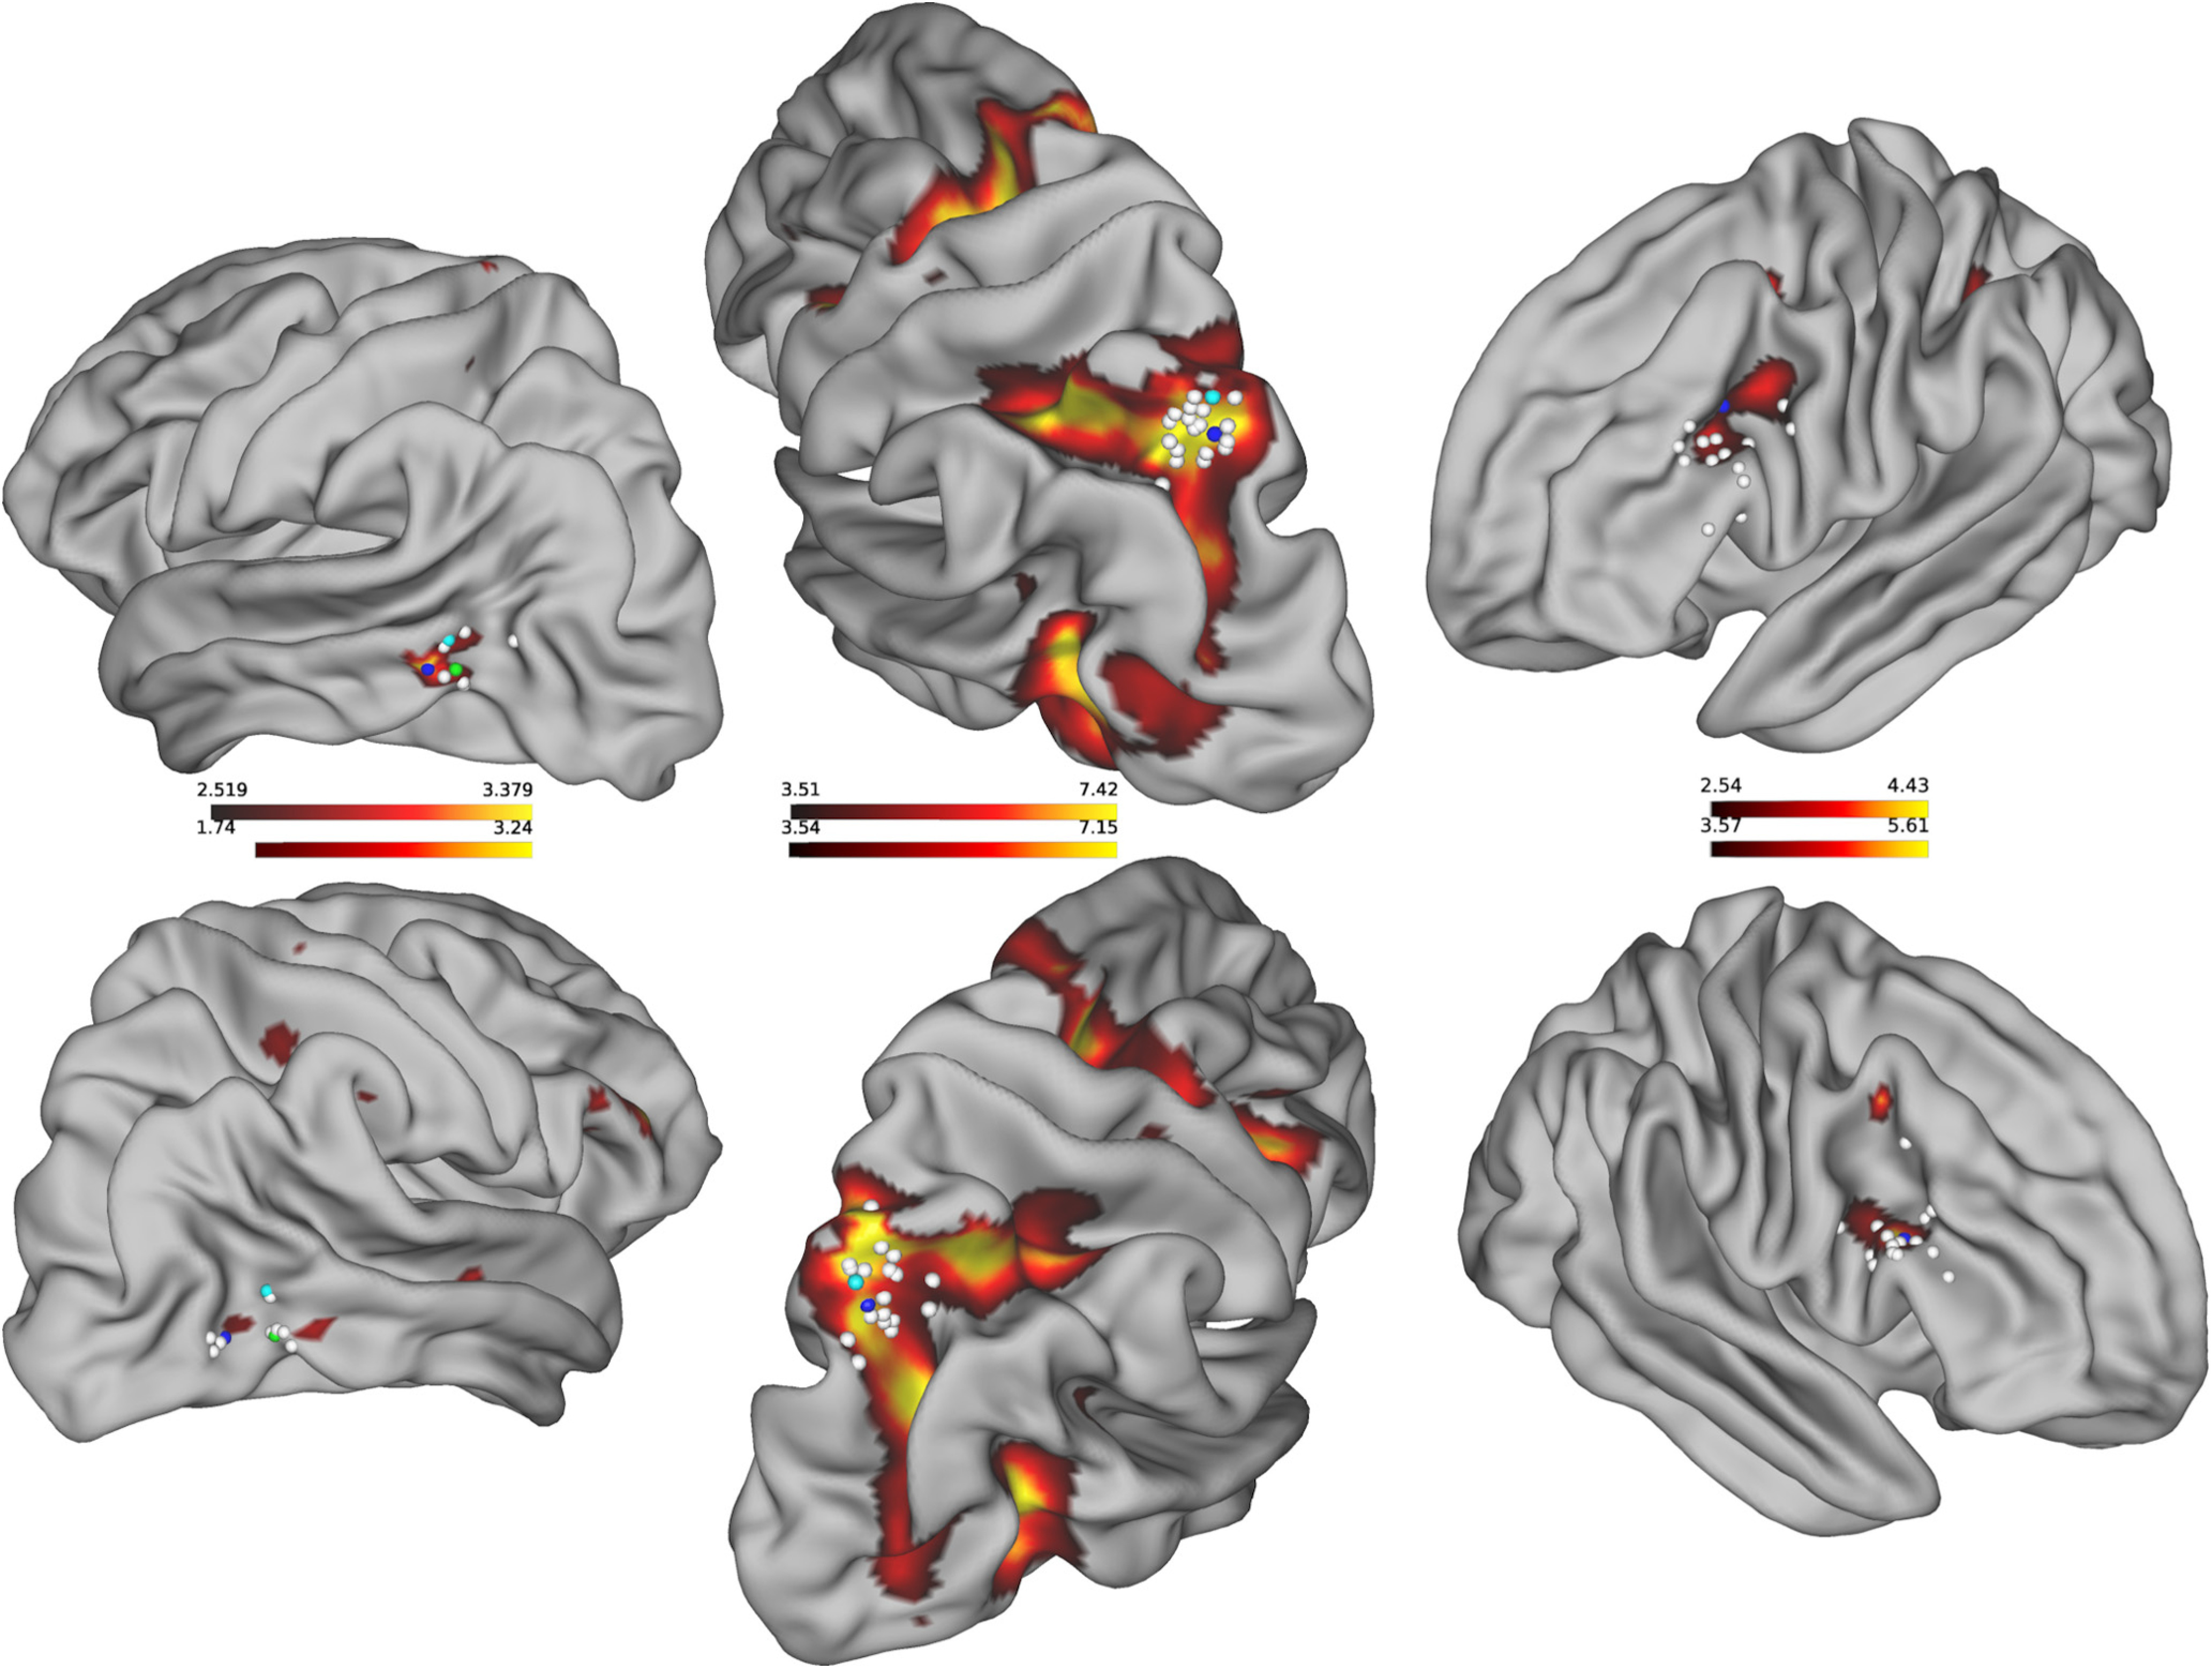
Activation maps emphasizing the ROIs. Left column, Contrast gaze following > color matching (localizer paradigm) used to identify the GFP. Blue dots mark maximum activation on the group level closest to locations taken from literature [green dots (Marquardt et al., 2017) and cyan dots (Materna et al., 2008)], white dots mark the maximum activation of those locations which were identifiable on the individual level. Middle column, Contrast gaze following > baseline fixation (localizer paradigm) used to identify saccade-related activity in the hLIP closest to location taken from (cyan dot; Sereno et al., 2001). Blue and white dots mark again, group level and individual coordinates. Right column, ambiguous-uninformative > unambiguous (contextual gaze following paradigm). Blue and white dots mark the group level and individual locations of the maximum IFJ-activity. See Extended Data Figure 3-1 for tabular form of all activated regions of each contrast and Extended Data Figures 3-2, 3-3, 3-4 for the respective contrast maps.